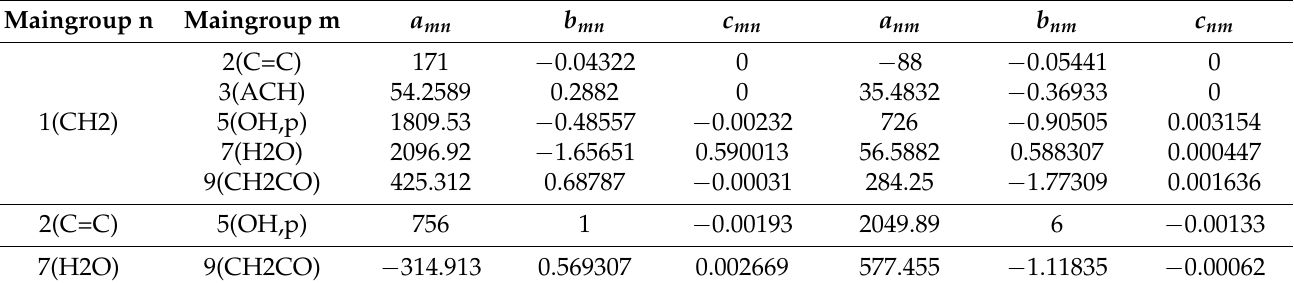
Table 2. Energy interaction parameters for the relevant main groups.